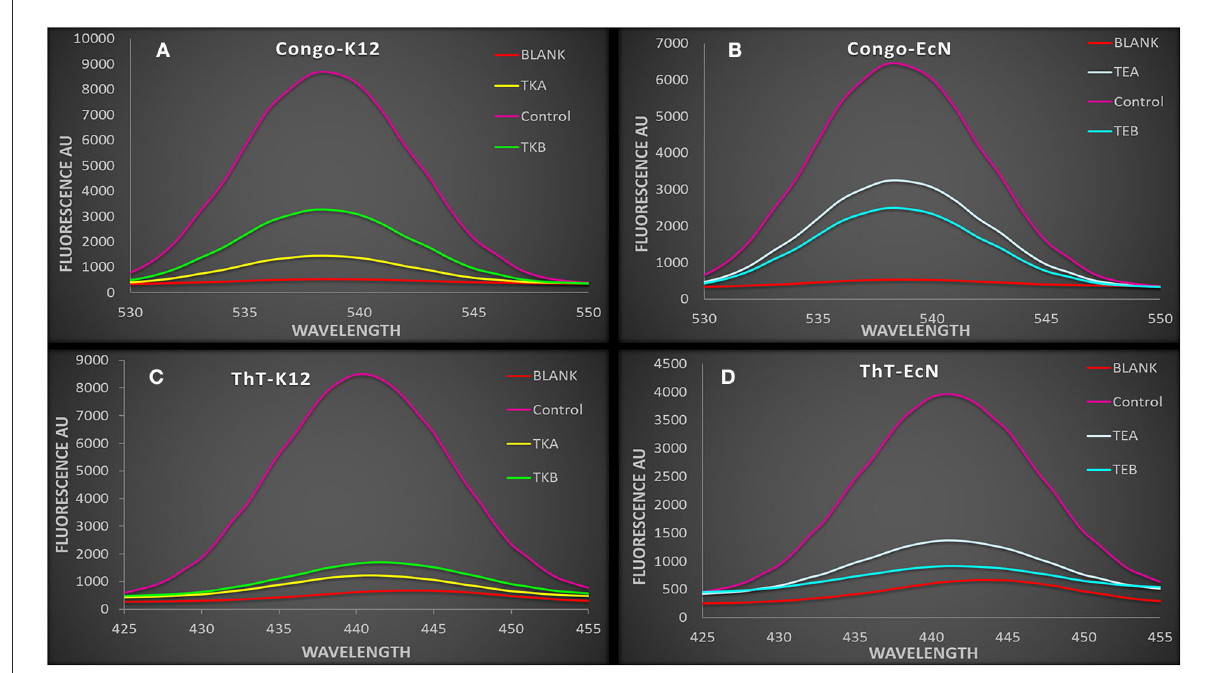
FIGURE3 (A,B) The spectra showing Congo red fluorescence assay of csgD -KD cells. The control cell showed a higher fluorescence intensity as compared to the csgD -KD cells (A) Congo red fluorescence assay of csgD -KD cells of K12 (TKA and TKB) (B) Congo red fluorescence assay of csgD -KD cells of EcN (TEA and TEB). (C,D) The spectra are showing ThT (thioflavin) fluorescence assay in csgD -KD cells. The decline in fluorescence spectra intensity suggests lower curli amyloid production in csgD -KD cells, (C) ThT fluorescence assay of TKA and TKB, (D) ThT fluorescence assay of TEA and